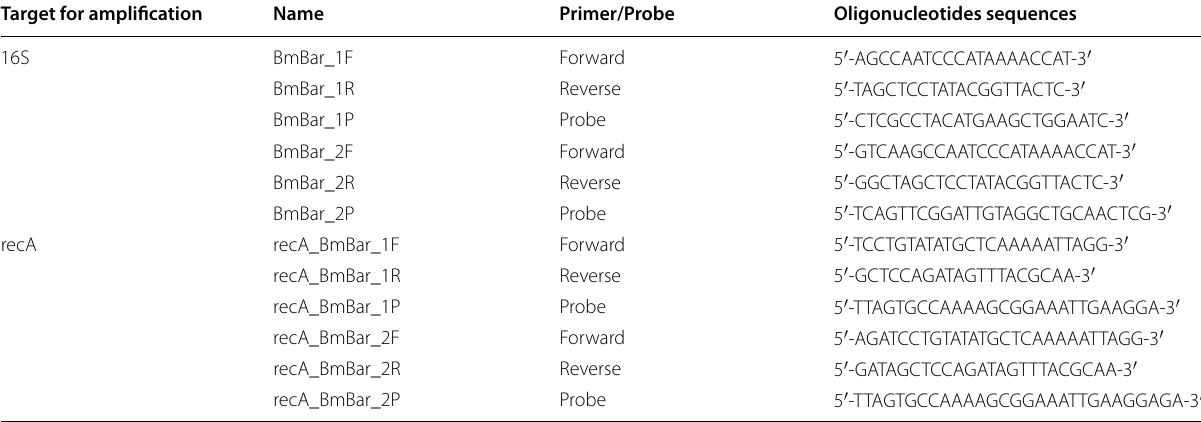
The first column shows the reference numbers of the ash mother trees in the Earth Trust’s clonal archive of British and Irish ash trees, which provided the seeds used in this study. The second column shows the number of individual clonal ash shoot lines per half-sib family that were tested for their ability to root under in vitro conditions. The last column shows the in vitro rooting trials in which these clones were tested. The number of individual clones tested varied between 7 and 12 per family in most cases, depending on the availability of material. Note that the in vitro ash shoot clones used in trials 3, 4, 5, 6, and 7 were affected by contamination, and so they are not included